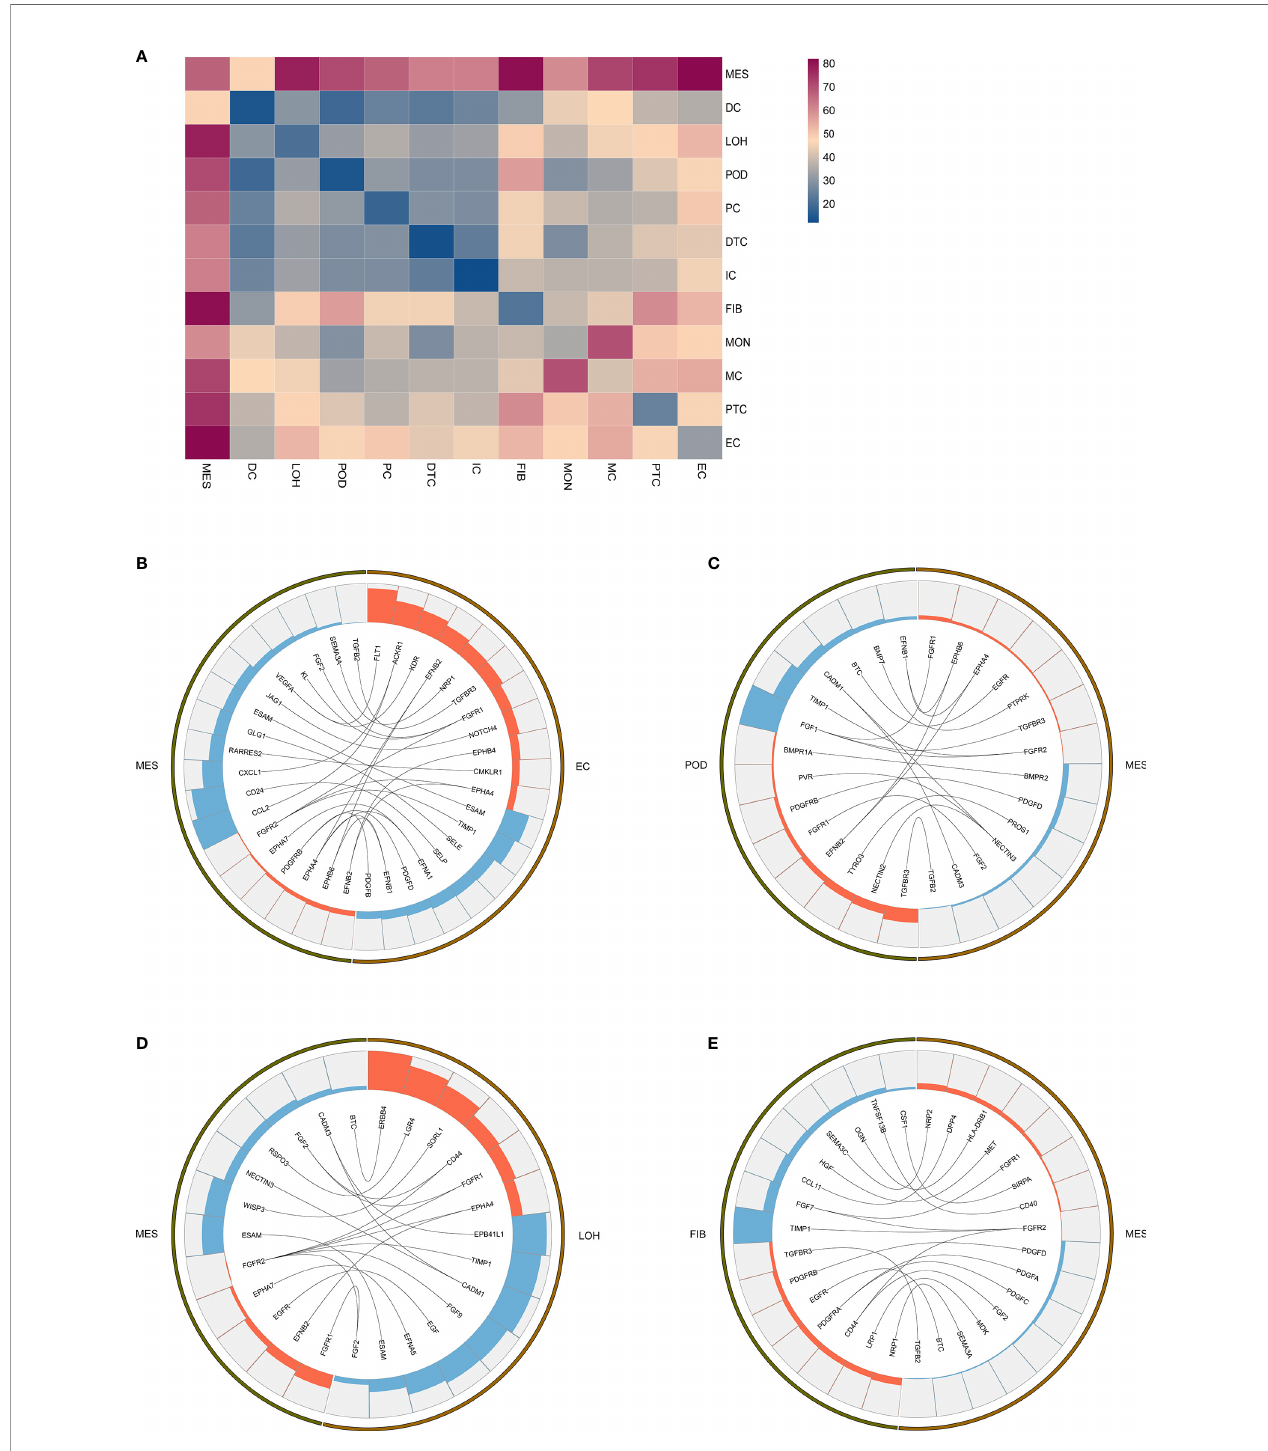
FIGURE 4 | Possible ligand-receptor interactions between different cell types in the kidney of IgAN patients. (A) Ligand-receptor signaling pathways between cell clusters in the kidney were analyzed and shown. (B) Representative ligand-receptor interactions between mesangial cells and endothelial cells. (C) Representative ligand-receptor interactions between mesangial cells and podocytes. (D) Representative ligand-receptor interactions between mesangial cells and loop of Henle cells. (E) Representative ligand-receptor interactions between mesangial cells and fi broblasts. Lines represented interrelations between the mesangial cells and other cells. Lines between the ligand and conjuncted receptor were shown. Each cell type was depicted by colors. Only IgAN patients (n = 4) were